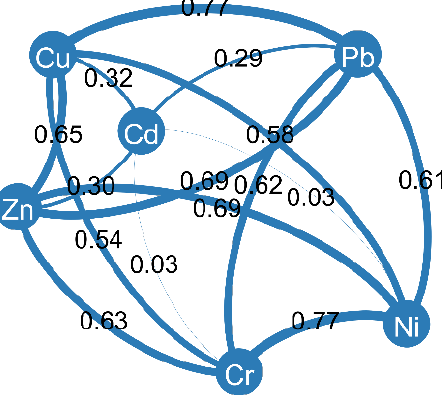
Figure 3. Spearman correlation analysis results.